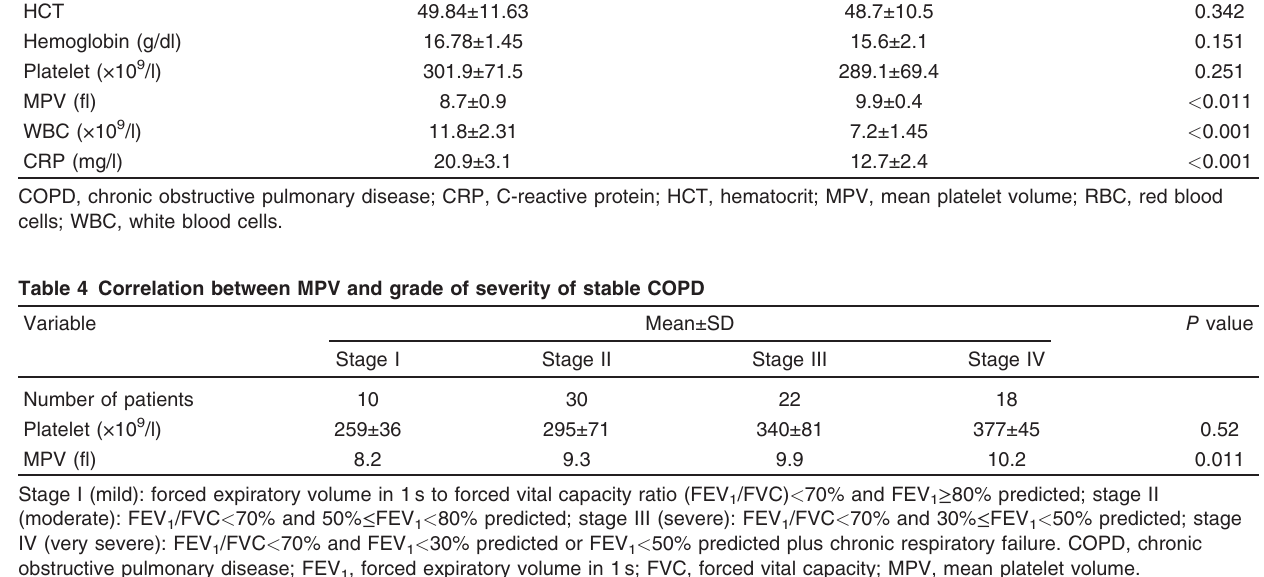
Table 5 Prevalence of pulmonary arterial hypertension among the studied stable COPD patients (80 patients) Variables Patients with Patients without pulmonary pulmonary arterial hypertension [ n arterial hypertension [ n (%)]